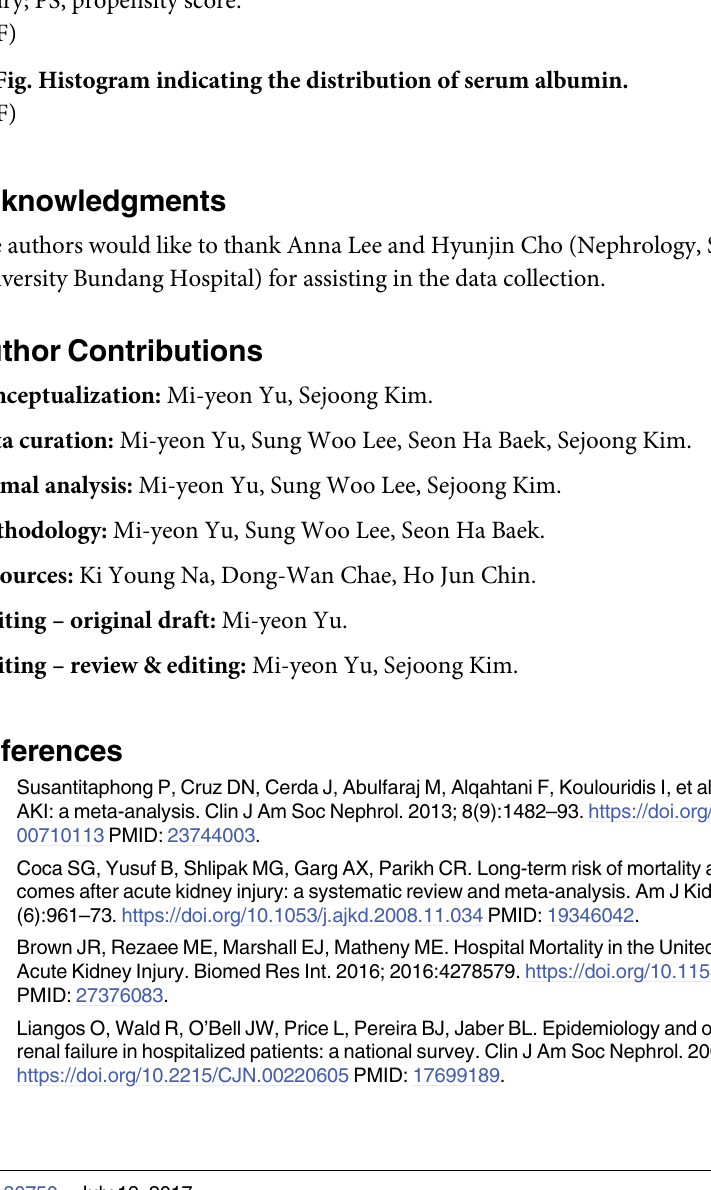
S1 Table. Basic characteristics of patients with AKI according to albumin replacement. AKI, acute kidney injury. S1 Fig. Distribution of PSs in AKI patients before and after PS matching. AKI, acute kidney injury; PS, propensity score. S2 Fig. Histogram indicating the distribution of serum